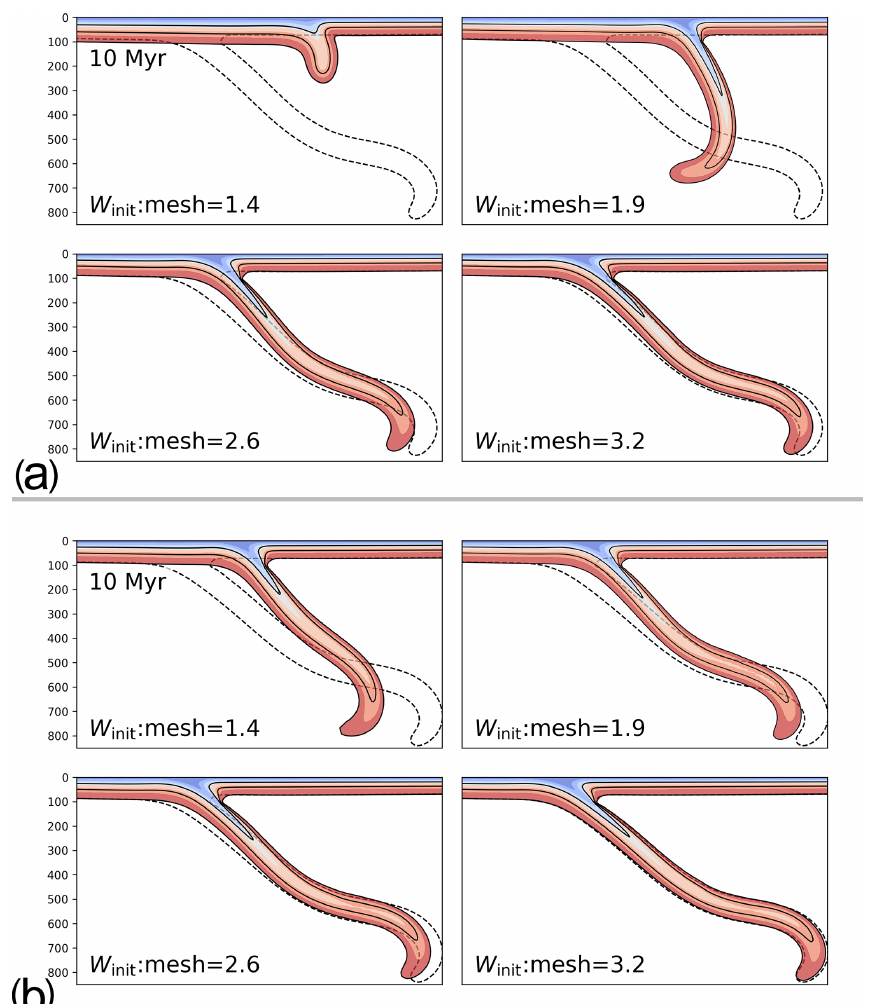
Figure 11. Implementation comparison with variable resolution. Colour map shows slab temperature field at 10Myr, masked above 1250 ◦ C. Each figure shows a series of models run at different resolutions. The total number of elements in the vertical coordinate was 96, 127, 160, and 192. Corresponding subduction interface resolution is displayed in the figure, representing the initial fault thickness ( W init ) divided by the local element size. (a) Models using standard WL implementation. (b) Models using the EF implementation.